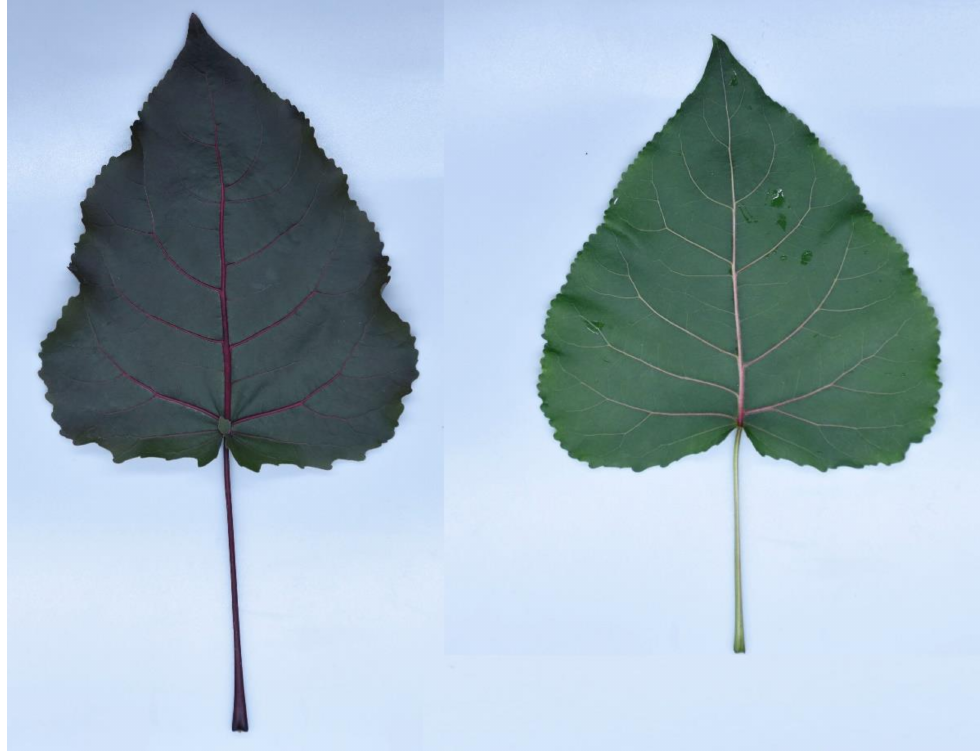
Figure 1. Typical appearances of ‘ZHP’ ( left ) and ‘L2025’ ( right ) seedling